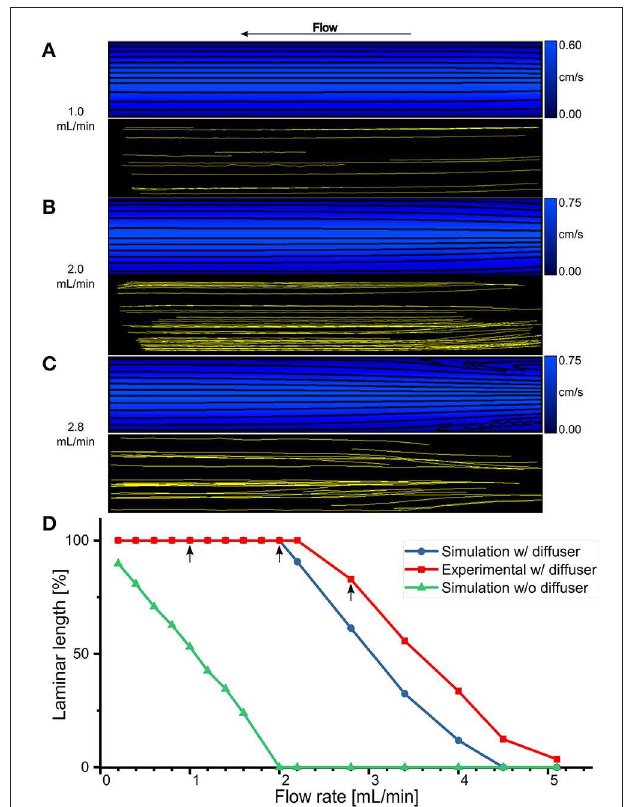
FIGURE 3 | Steady-state and fully-developed laminar flow. (A–C) Comparison of CFD flow simulation (top) and experimental µ PIV (bottom) for the imaging slit of the flow chamber with pyramidal diffusers at three different flow rates: 1.0, 2.0, and 2.8 mL/min, respectively. (D) Laminar length for an imaging slit without diffuser (green line, triangles) were obtained solely with simulations. Laminar length within the imaging slit with diffusers as a function of flow rate obtained with CFD simulations (blue line, circles) and experimental µ PIV (red line, squares). Arrow indicates the flow rates shown in (A–C)